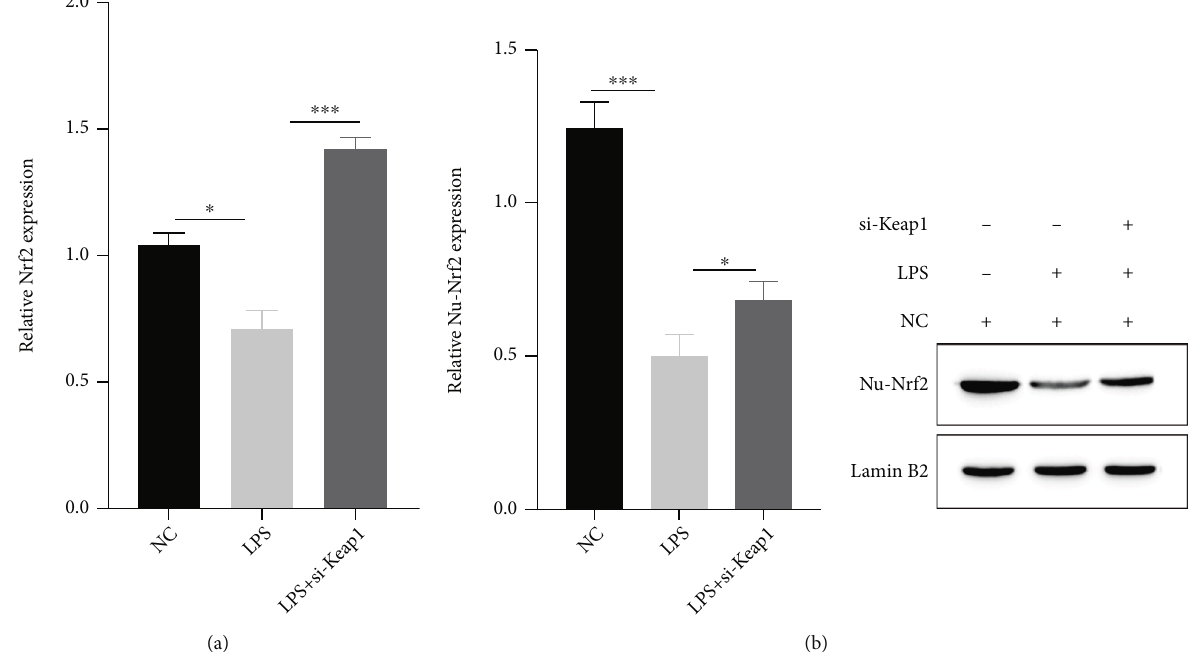
Figure 2: si-Keap1 reduces the inhibitory e ff ect on the Nrf2-ARE signaling pathway. (a) RT – qPCR analysis of Nrf2 mRNA expression under NC, LPS, and LPS+Keap1 conditions; (b) expression of the signaling pathway protein Nrf2 under NC, LPS, and LPS+Keap1